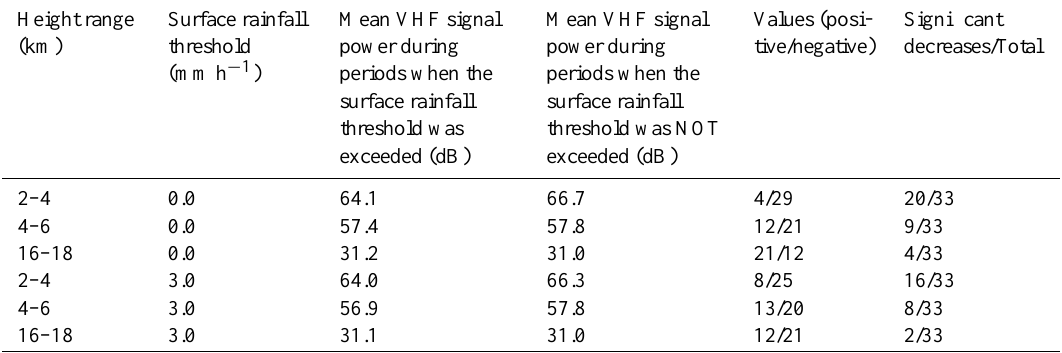
Table 1. The mean VHF signal power is shown averaged over the height range indicated during periods where the indicated rainfall threshold was and was not exceeded. In addition, the number of positive and negative changes are shown in the mean signal power associated with rainfall and the number of significant decreases in the signal power associated with periods of surface rainfall above the indicated threshold. The surface rainfall is observed by a tipping bucket rain gauge co-located with the VHF